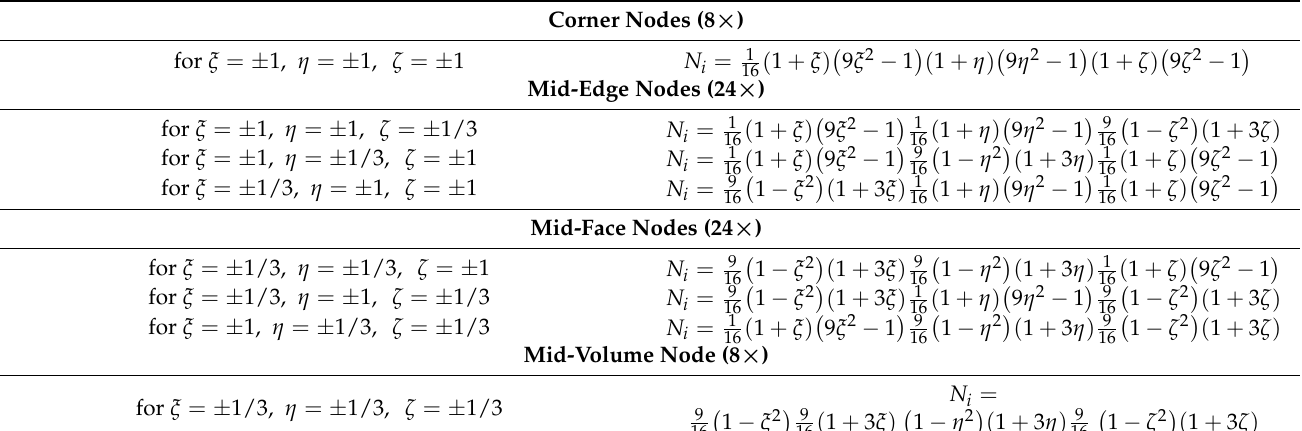
Table A3. The shape functions of the 64-node brick FE. Figure A3. Cartesian global and local curvilinear coordinates of the 64-node brick FE.